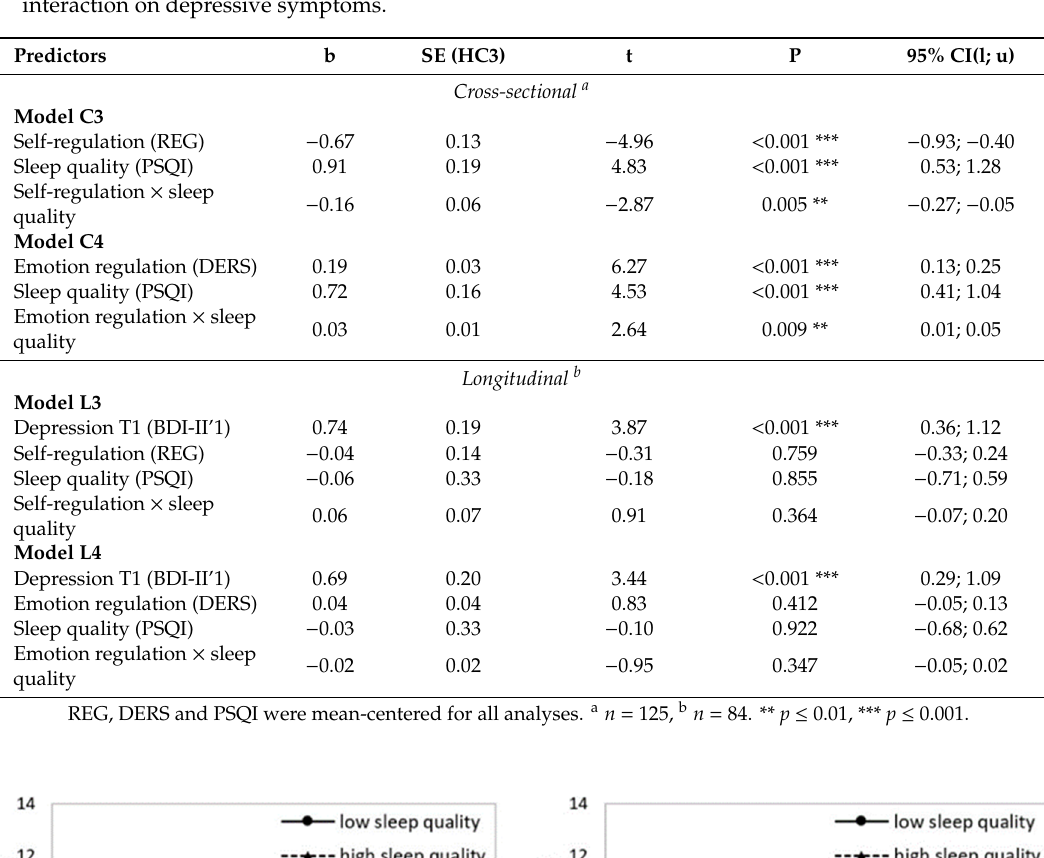
Table 3. E ff ects of self-reported impaired regulatory processes, subjective sleep quality, and their interaction on depressive symptoms.